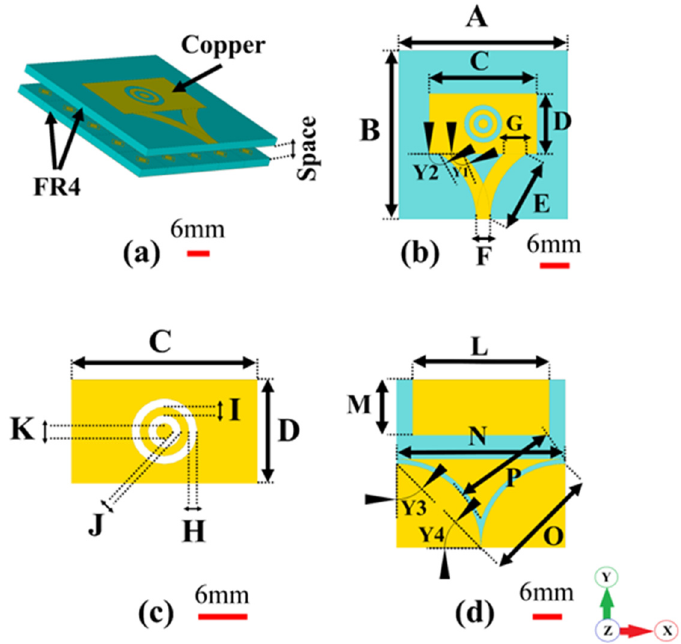
Figure 2. Geometric structure of the proposed microstrip patch antenna: ( a ) perspective view, ( b ) front view, ( c ) microstrip patch, ( d ) backside view.